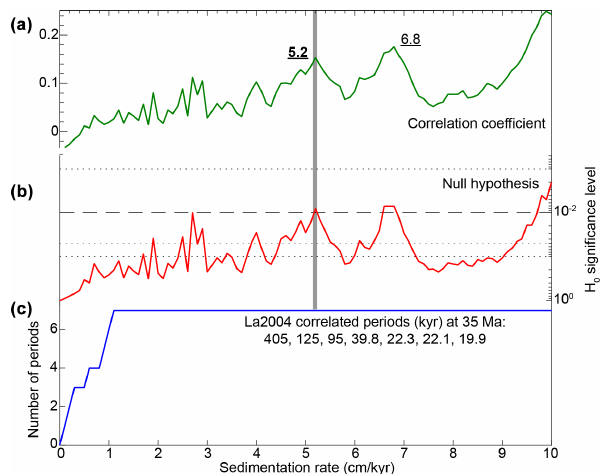
Figure 4. Statistical testing for astronomical forcing hypothesis of NGR variations, and optimal sedimentation rate for orbitally forced NGR time series using the COCO technique (Li et al., 2018; see Methods). (a) Pearson correlation coefficient. (b) Null hypothesis H 0 . (c) Number of La2004 astronomical parameters used in the cor- relations (indicated). Note there are two optimal sedimentation rates at 5.2 and 6.8cmkyr − 1 , which have significant H 0 levels above 10 − 2 . The optimal sedimentation rate at 5.2cmkyr − 1 (vertical grey bar) fits the visual mean sedimentation rate (see Fig.